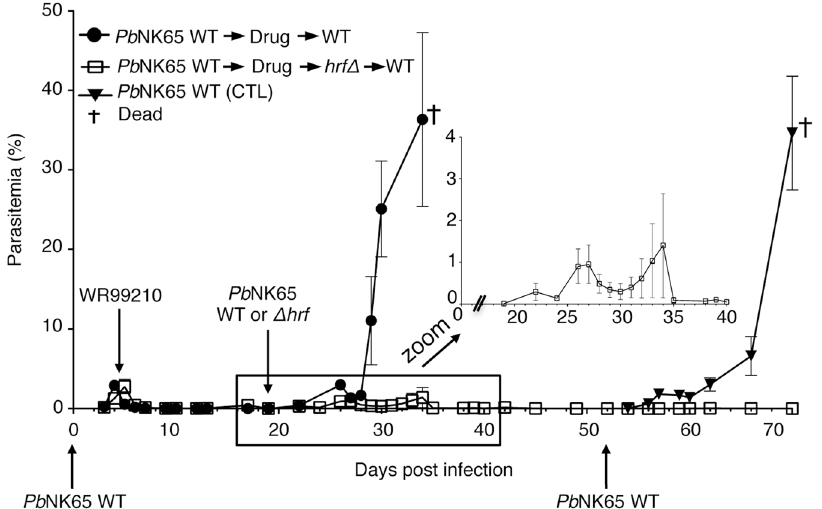
Figure 2. Prior exposure to WT parasite followed by drug treatment does not hamper Pb NK65- hrf Δ -induced parasite clearance and immune protection. Blood-stage parasitemia of C57BL/6 mice after i.p. injection of 10 5 WT iRBCs and treated at day 4 p.i. with 6 mg/kg WR99210 by subcutaneous injections for three consecutive days. At day 19 p.i. mice that have eliminated the parasite from blood stream after drug treatment were infected with either with 10 5 WT or Pb NK65 hrf Δ iRBCs. Mice infected with Pb NK65 hrf Δ parasites were subsequently, after parasite elimination from blood stream, challenged at day 52 p.i. with 10 5 WT iRBCs. Parasite